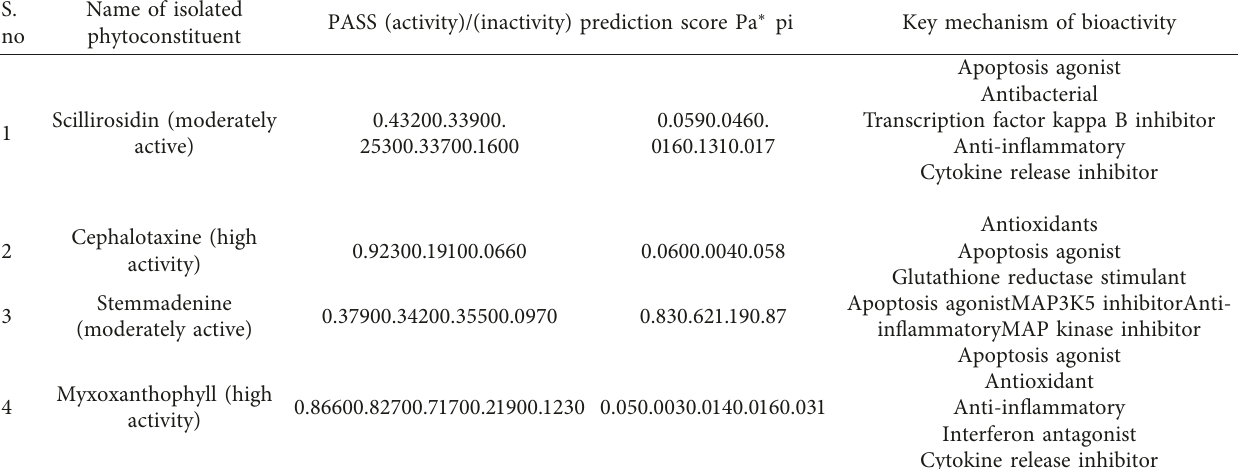
Table 9: PASS online predictivity score for bioactive compounds.